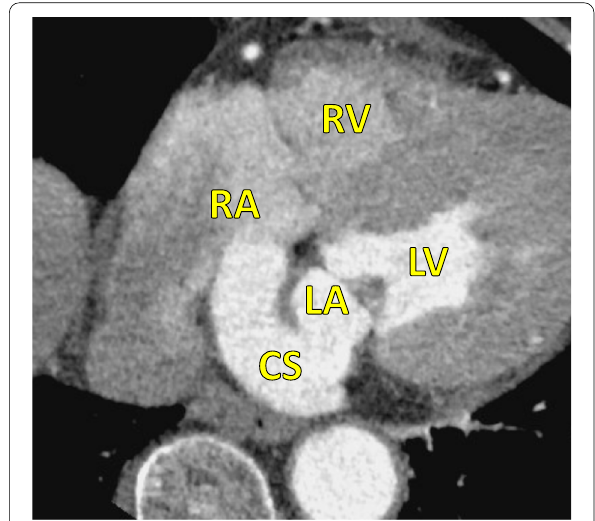
Fig. 1 Preoperative cardiac computed tomography. Preoperative cardiac computed tomography showed extensive communication between the right and left atria caused by partial absence of the roof of the coronary sinus. LA left atrium, LV left ventricle, RA right atrium, RV right ventricle, CS coronary sinus